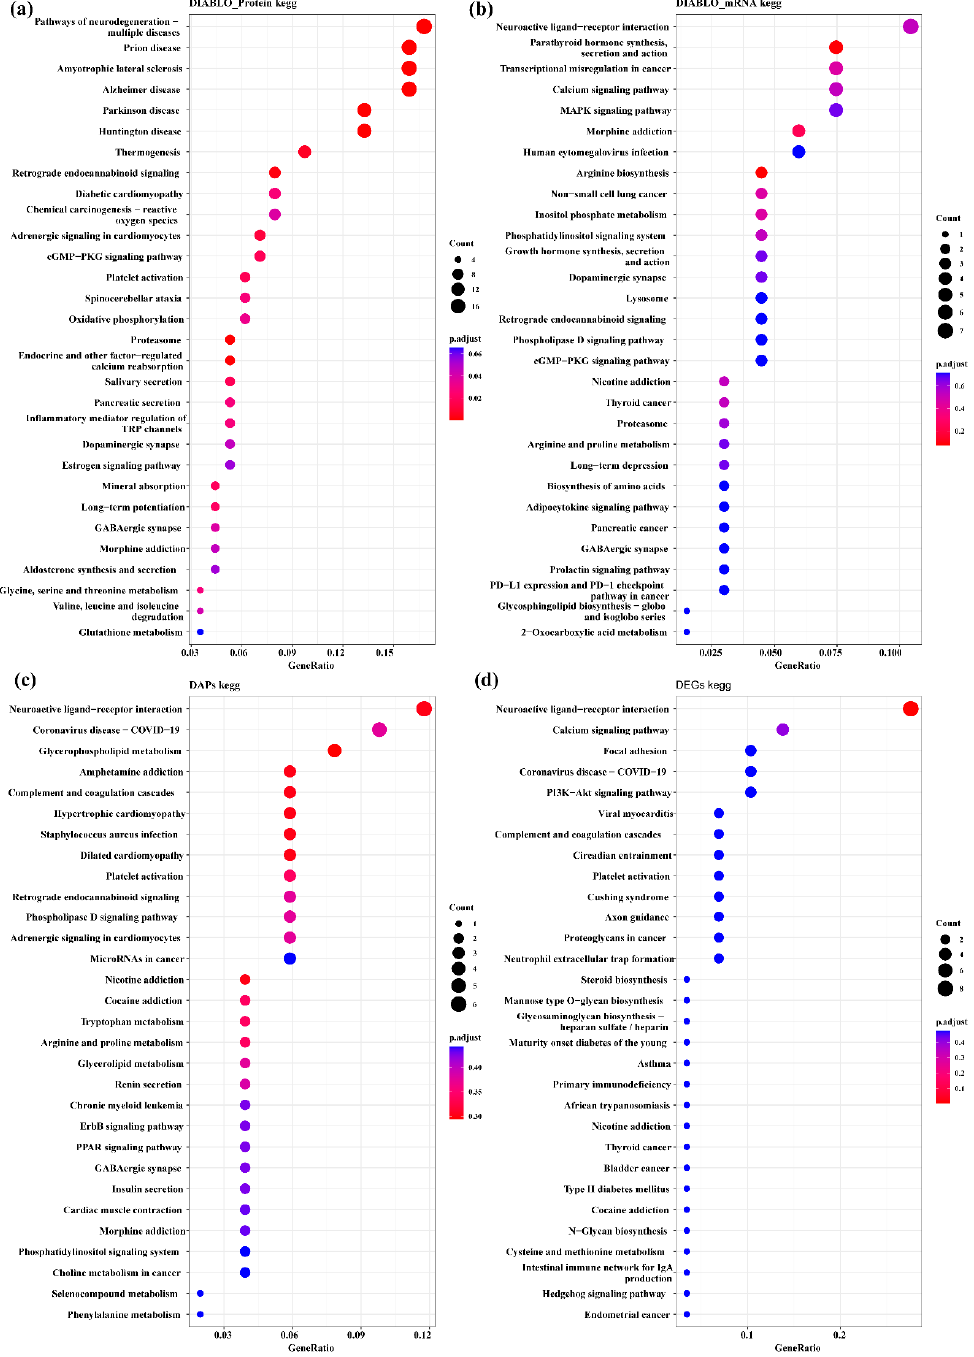
Figure 7. Top 30 enriched KEGG pathways of DAPs and DEGs of the interaction group and discrimi- nating variables (DIABLO_protein, DIABLO_mRNA) selected by DIABLO. ( a ) KEGG